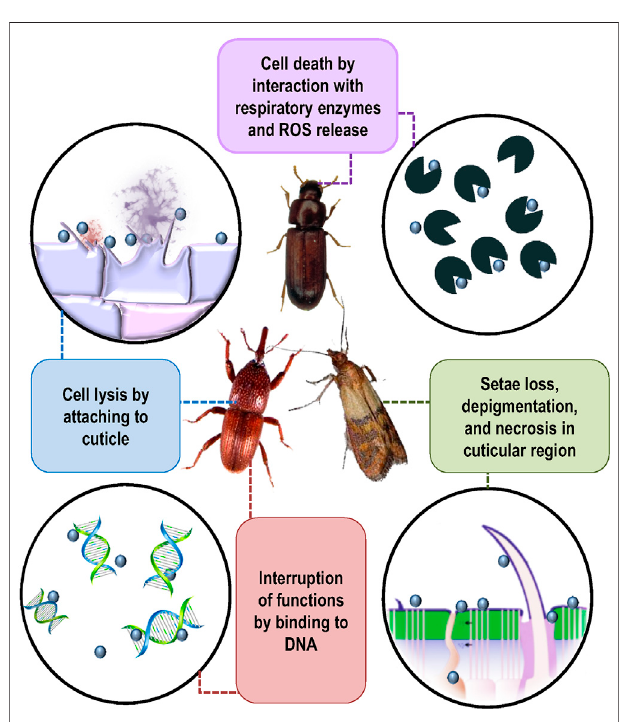
FIGURE 2 | Some modes of action of nanoparticles against storage insect pests.